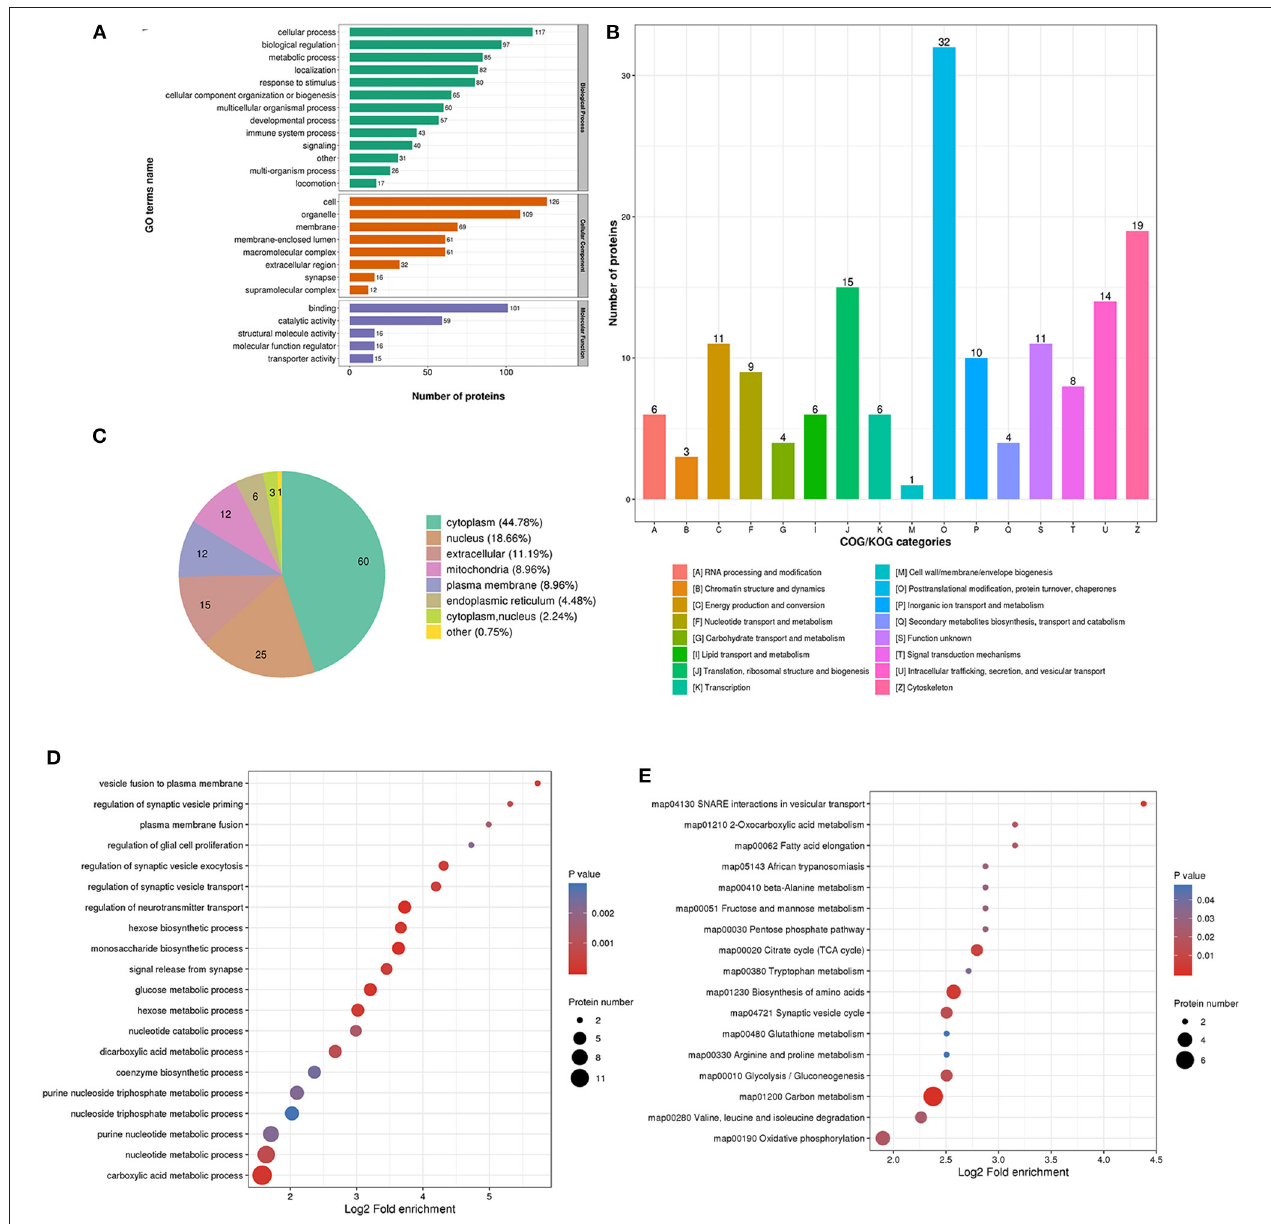
FIGURE 4 | Characterization and functional enrichment analysis of identified upregulated acetylated proteins in glioma-associated seizure. (A) The classification of upregulated acetylated proteins in biological process, cell components, and molecular function. (B) The categories of upregulated acetylated proteins in COG/KOG categories. (C) The distribution of upregulated acetylated proteins in subcellular localization. Upregulated acetylated proteins in glioma with seizures were classified by GO annotation based on (D) biological process and (E) the KEGG pathway